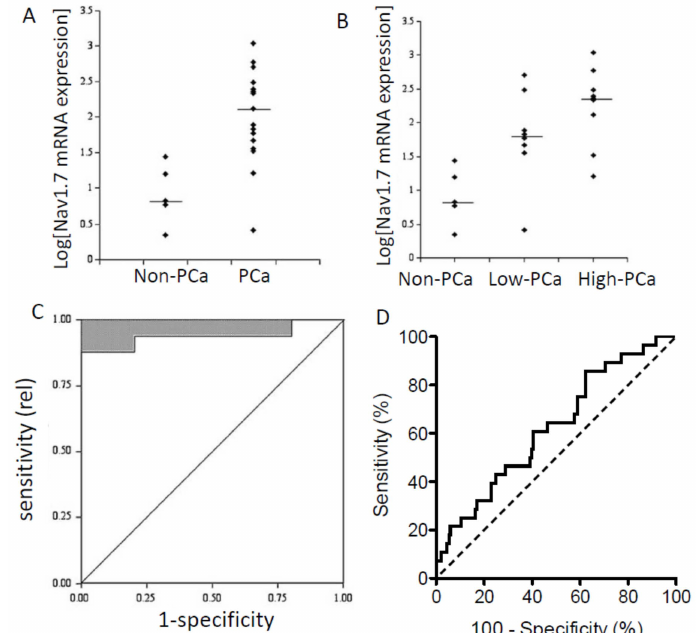
Figure 1. VGSC mRNA expression and associated ‘receiver operator characteristics’ of human prostate and breast cancers. ( A – C ) Data for human prostate cancer (PCa). Nav1.7 mRNA levels in non-PCa vs. PCa patient samples determined by real-time PCR. “Non-PCa” were mostly benign prostatic hyperplasia. Logarithmic plots of Nav1.7 expression levels normalized to beta-actin are shown. ( A ) Non-PCa vs. PCa. ( B ) Comparisons of non-PCa, low-grade PCa (Gleason grade < 6), and higher grade PCa (Gleason grade > 6). Medians are shown as short horizontal lines in both ( A ) and ( B ). ( C ) “Receiver operator characteristics” (ROC) analysis showing the potential diagnostic e ffi cacy of Nav1.7 mRNA expression in distinguishing non-PCa ( n = 5) from PCa ( n = 17). E ffi cacy is indicated by upper-left deviation from the non-discriminatory diagonal line. ( D ) ROC analysis as in ( C ) but for breast cancer ( n = 181). Modified from [16] ( A – C ), and [41] ( D